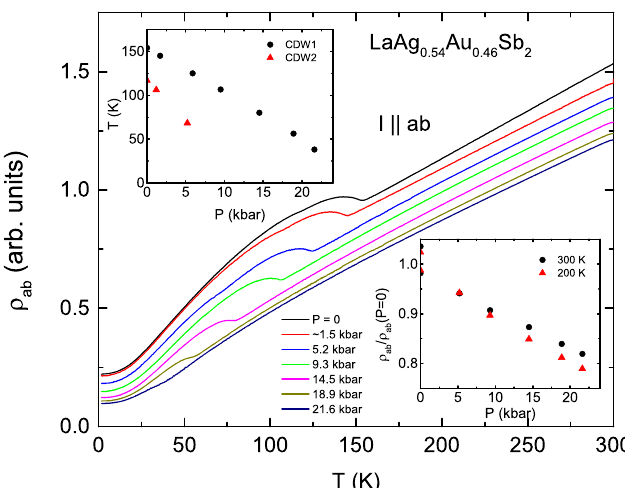
Figure 8. Temperature-dependent in-plane resistivity of LaAg 0.54 Au 0.46 Sb 2 measured at different applied pressures. Upper inset: CDW transition temperatures, T CDW 1 and T CDW 2 , as a function of pressure. Lower inset: normalized resistivity at 300 K and 200 K as a function of pressure. Note, some minor corrections of pressure values, following Ref. [17] were applied.